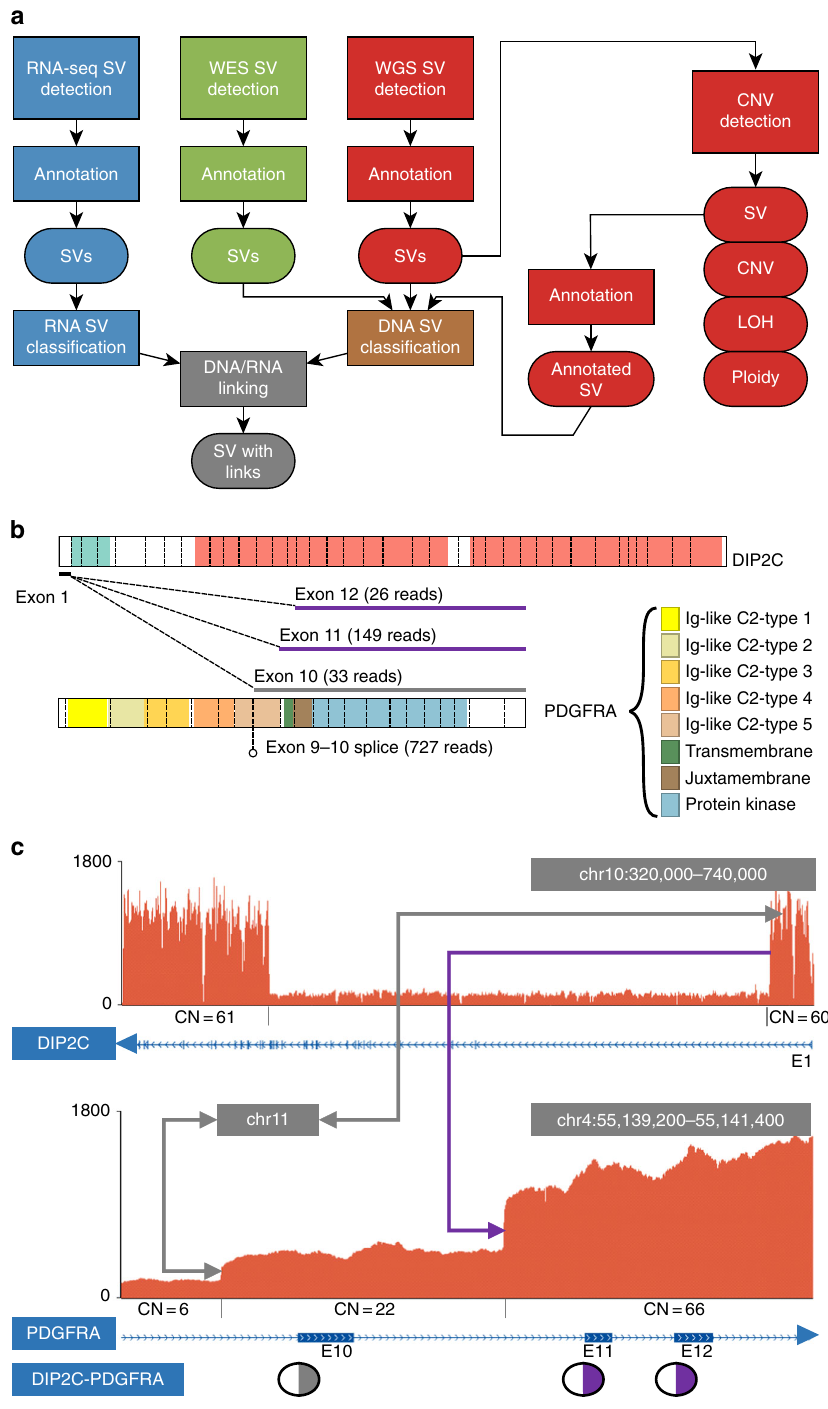
Fig. 2 Integrative analysis of structural variation. a Multi-platform, multi-analysis approach for detecting SV by three-platform sequencing. SV detection is run using RNA-Seq and WES of the tumor sample, and integrated SV and CNA detection are run using WGS of the tumor and normal samples. b , c An example of linking three fusion transcripts of DIP2C-PDGFRA detected in RNA-Seq to DNA SVs detected in WGS in a high-grade glioma. The fusion transcripts are shown in protein view ( b ) with the domains marked in color and the vertical dotted lines marking the boundaries of each exon with chimeric RNA read counts indicated above the PDGFRA ideogram and wildtype exon 9 – 10 read counts below. The fusion transcript involving PDGFRA exon 10 — marked by the gray line in the PDGFRA protein view ( b ) — is linked to a novel DNA SV involving chromosome 4, 11 and 10, shown using the gray line in ( c ), while the other two fusion transcripts, marked by the purple lines in ( b ), are linked to the same DNA SV involving chromosome 4 and 10, shown using the purple line in ( c